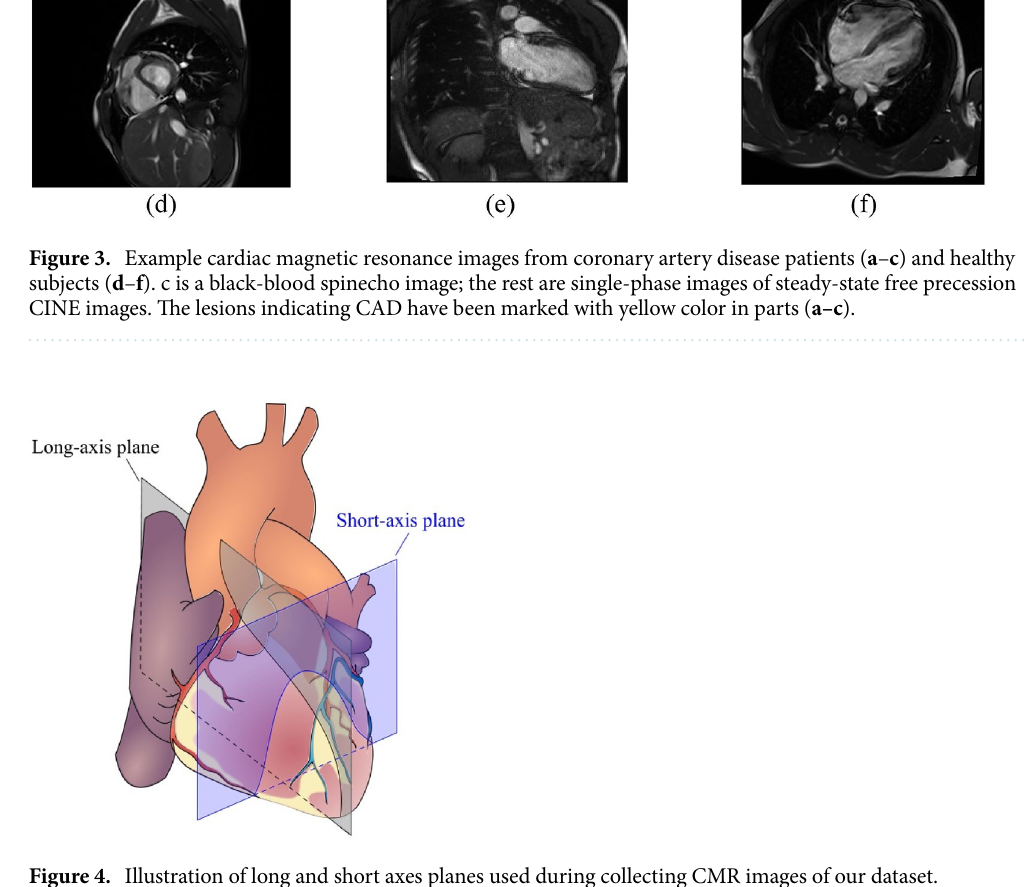
Figure 4. Illustration of long and short axes planes used during collecting CMR images of our